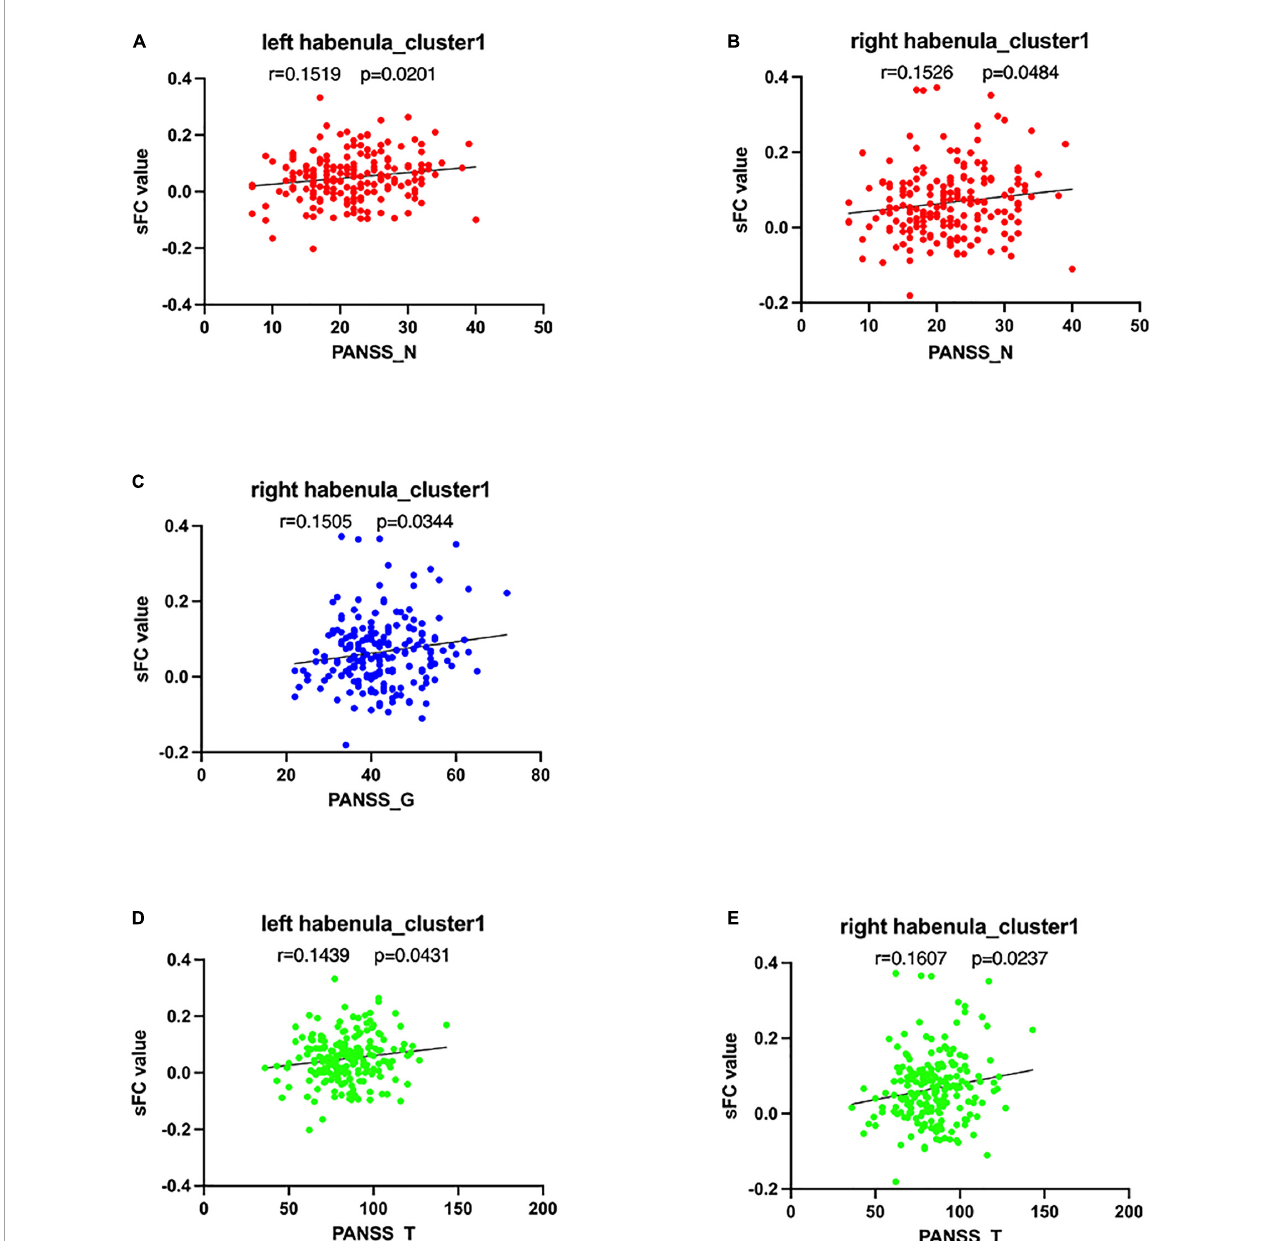
FIGURE3 Correlations between abnormal sFC, dFC, values and clinical variables. In schizophrenia patients, (A) a positive correlation was observed between the sFC values in the cluster1 using left habenula as seed and PANSS negative sub-scores, (B) a positive correlation was observed between the sFC values in the cluster 1 using right habenula as seed and PANSS negative sub-scores, (C) a positive correlation was observed between the sFC values in the cluster1 using right habenula as seed and PANSS general sub-scores, and (D) a positive correlation was observed between the sFC values in the cluster1 using left habenula as seed and PANSS total scores, (E) a positive correlation was observed between the sFC values in the cluster1 using right habenula as seed and PANSS total scores.